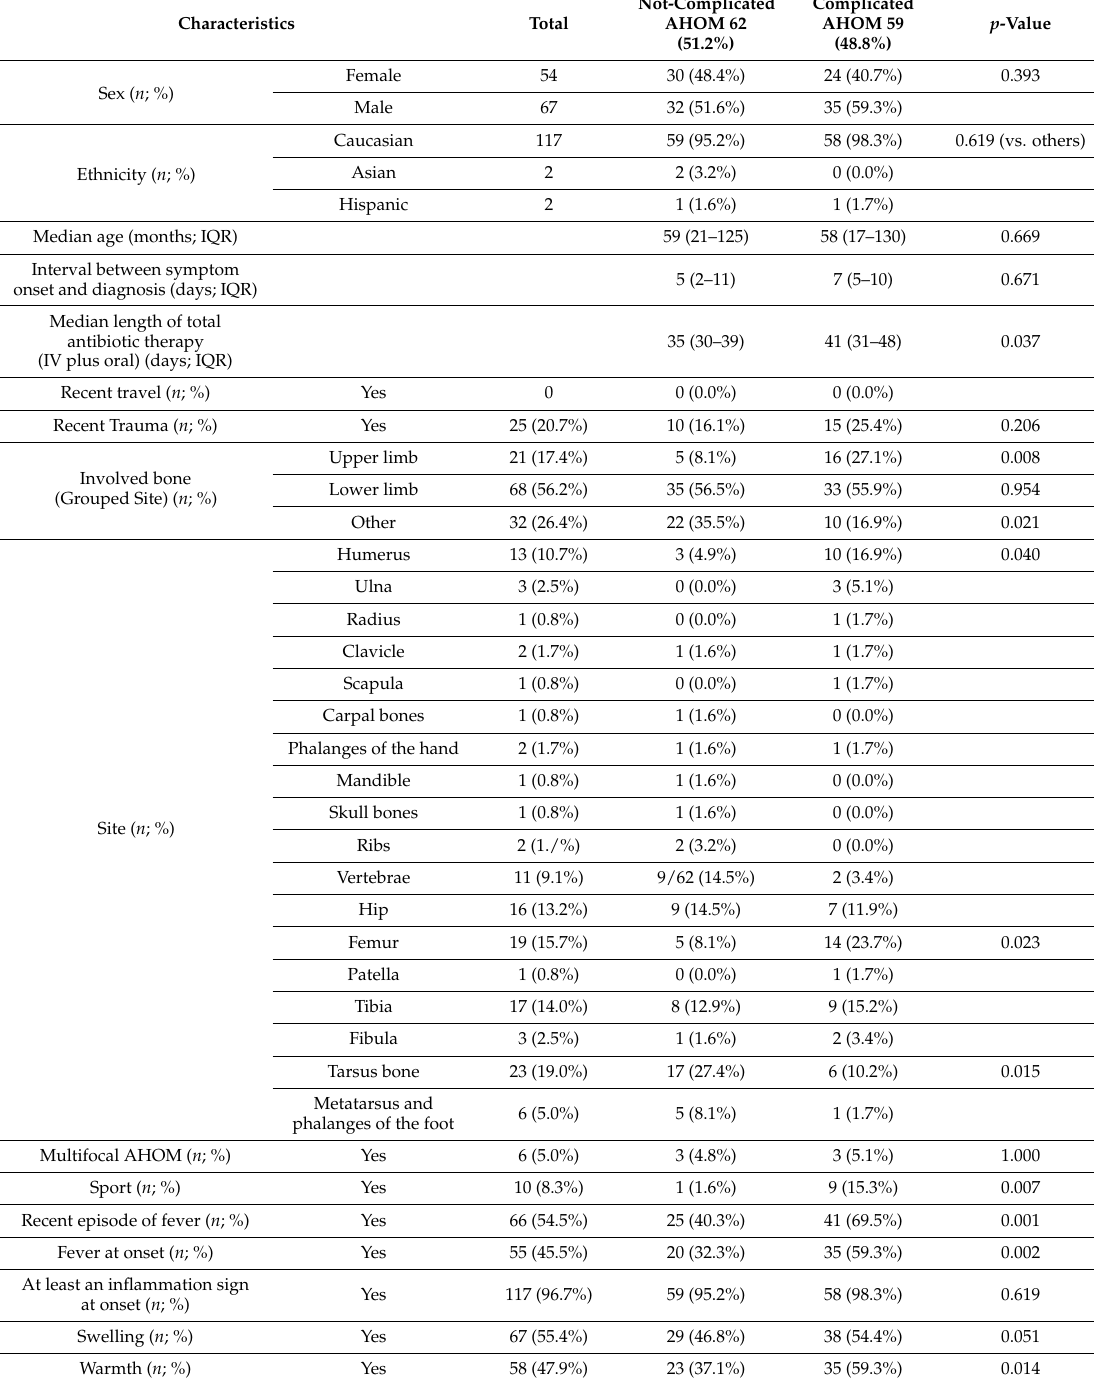
Table 1. Characteristics of the 121 study children admitted to a single tertiary Center with acute osteomyelitis